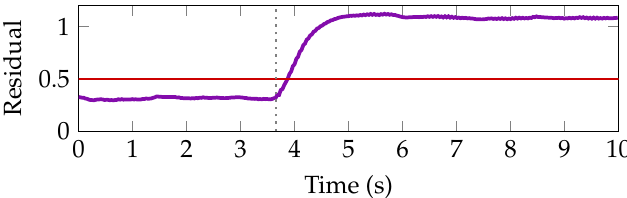
Figure 13. Residual signal in a closed-loop experiment and a actuator stuck fault scenario compared to the selected threshold (